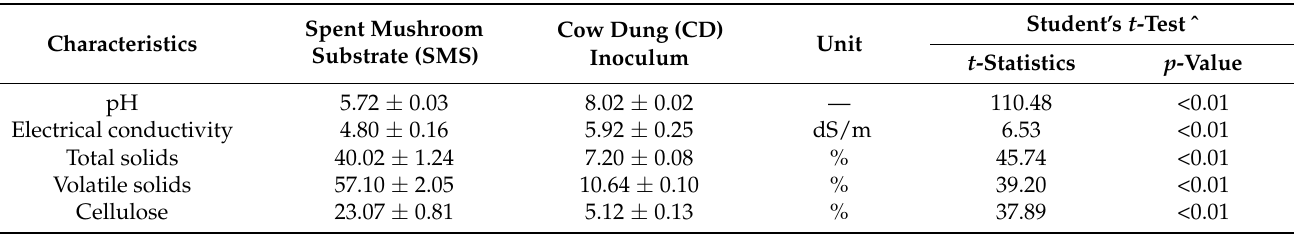
Table 1. Physicochemical and proximate characteristics (mean ± SD; n = 3) of the Shiitake SMS and CD used in this